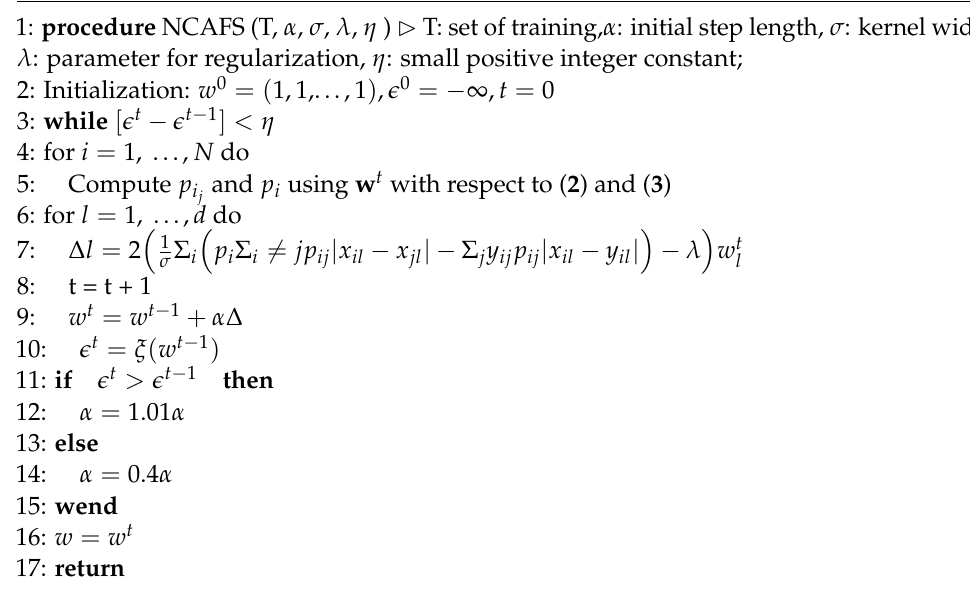
Algorithm 1 : NCA Feature Selection